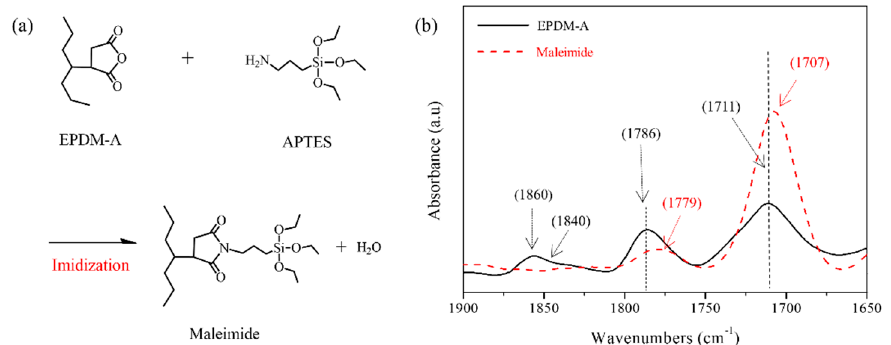
Figure 8. Schematic for the imidization of the MAH groups of EPDM-A and amine groups of APTES ( a ) and FT-IR spectra of EPDM-A (black) and maleimide synthesized from reaction between EPDM-A and APTES (red dot line) ( b ).